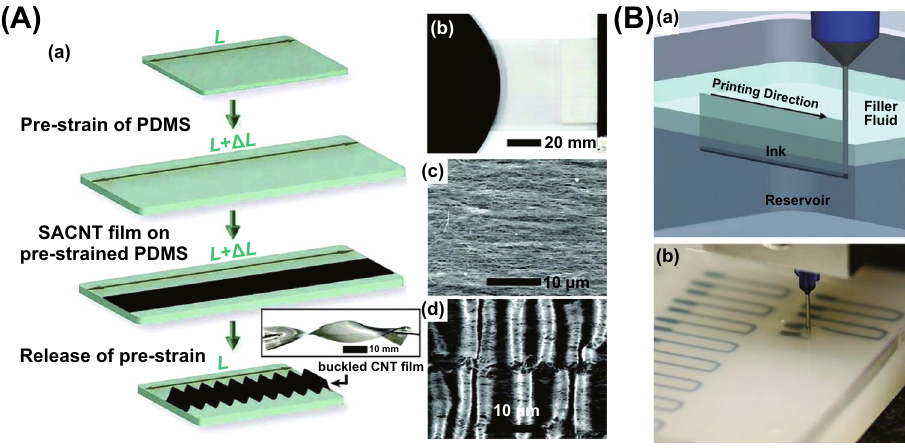
Fig. 10 A Schematic illustration for preparing polydimethylsiloxane/super-aligned carbon nanotube (PDMS/SACNT) composites films ( a ), the photograph of SACNT film ( b ), SEM images of SACNT film ( c ) and the buckled SACNT structures on a PDMS film after releasing pre-strain ( d ). B Sketch of the embedded 3D printing process with printing a conductive ink within an uncured elastomeric reservoir capped by filler fluid ( a ) and for preparing a planar array of strain sensors ( b ). Reprinted with permission from Ref.